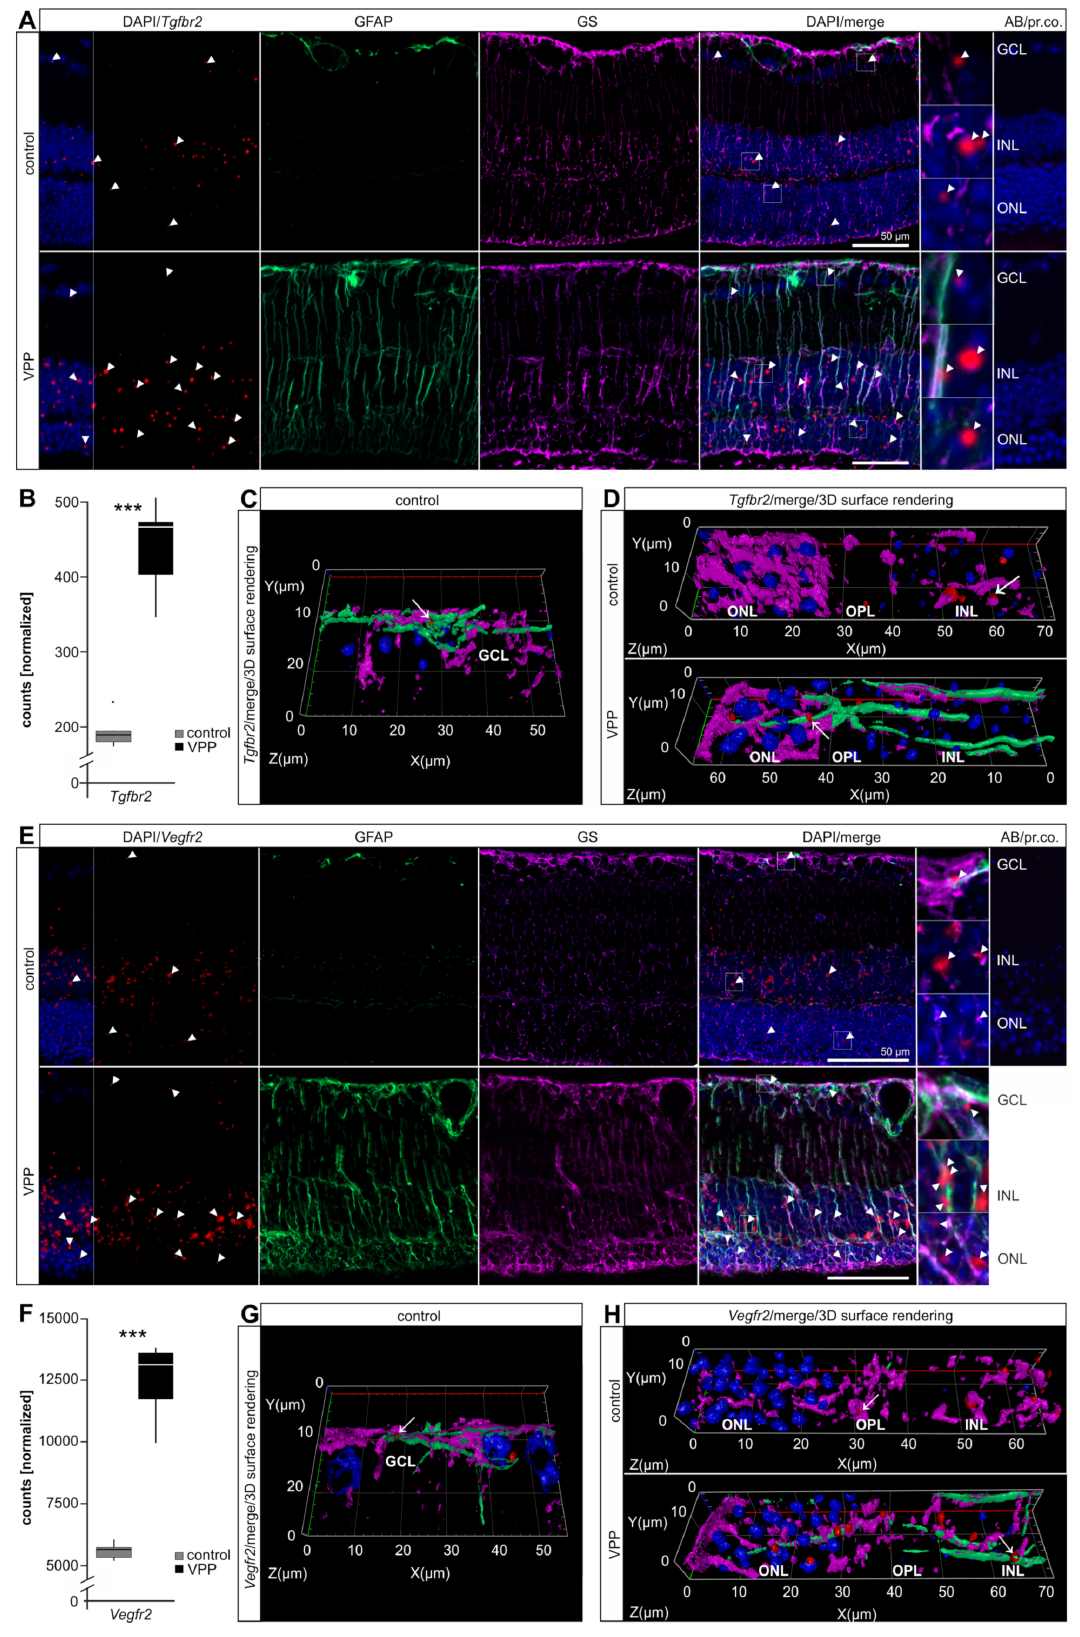
Figure 4. Upregulation of TGF β - and VEGF-signaling in VPP mice. ( A ) In situ hybridization for Tgfbr2 (red, arrowheads) and GFAP (green)/GS (purple) immunofluorescence co-labeling in the retinae of three-month-old animals. Nuclei